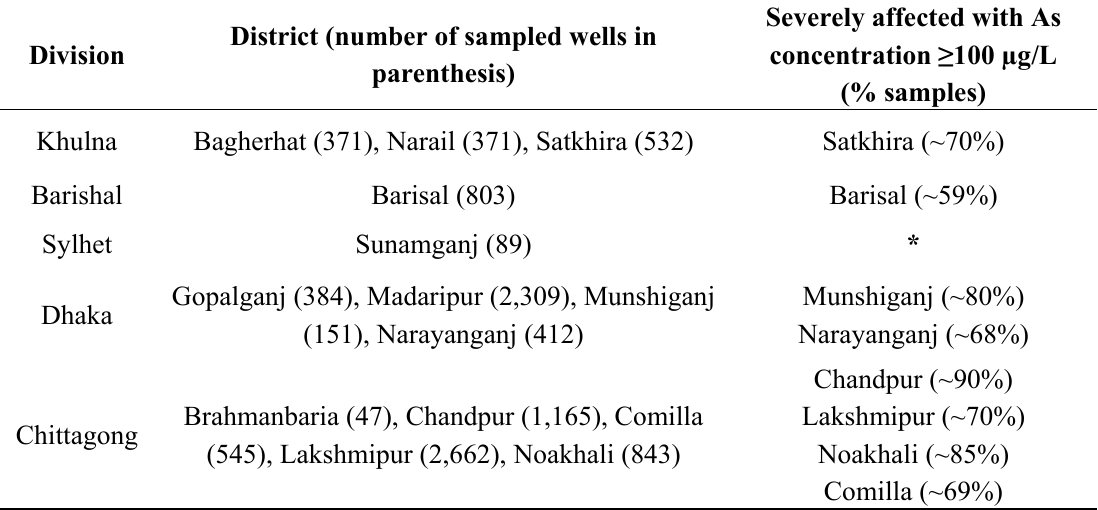
Table 1. Major As contaminated districts with >50% analyzed samples exceeding Bangladesh guideline value (50 µg/L)